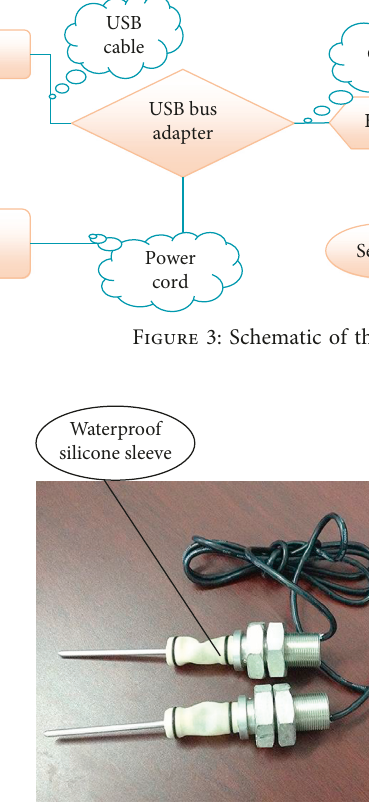
Figure 4: Digital photo of the displacement sensor.